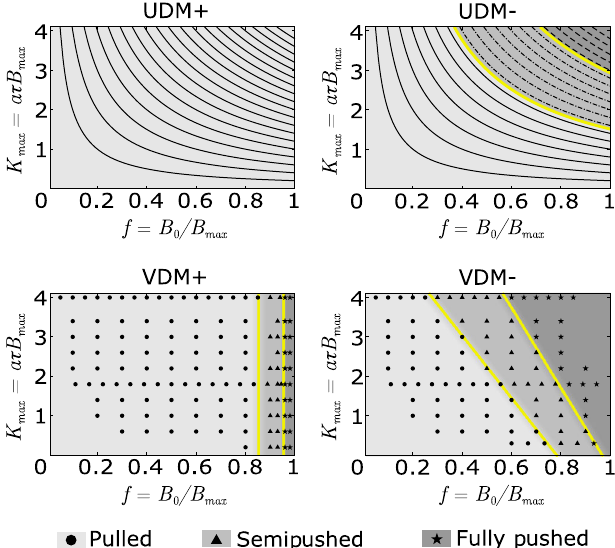
FIG. 3. Phase diagrams showing the expansion types for the four model variants as a function of the initial bacterial density f — burst and maximum dimensionless adsorption coefficient K max size β ¼ 50 throughout. Lines in the UDMs and data points in the VDMs indicate the parameter combinations for which numerical integration is performed and velocities calculated. These values are interpolated to estimate the transition boundaries between different classes of traveling waves (yellow lines). In the UDM þ , we do not observe pushed waves, while in the VDM þ transitions between pulled and pushed waves occur at approximately constant bacteria fractions. In the UDM − , as K and β are the only free parameters, transitions occur at specific values of K . In the VDM − , the transitions are heuristically approxi- mated as linear relationships with gradient m and intercept a ( f ¼ mK þ a max